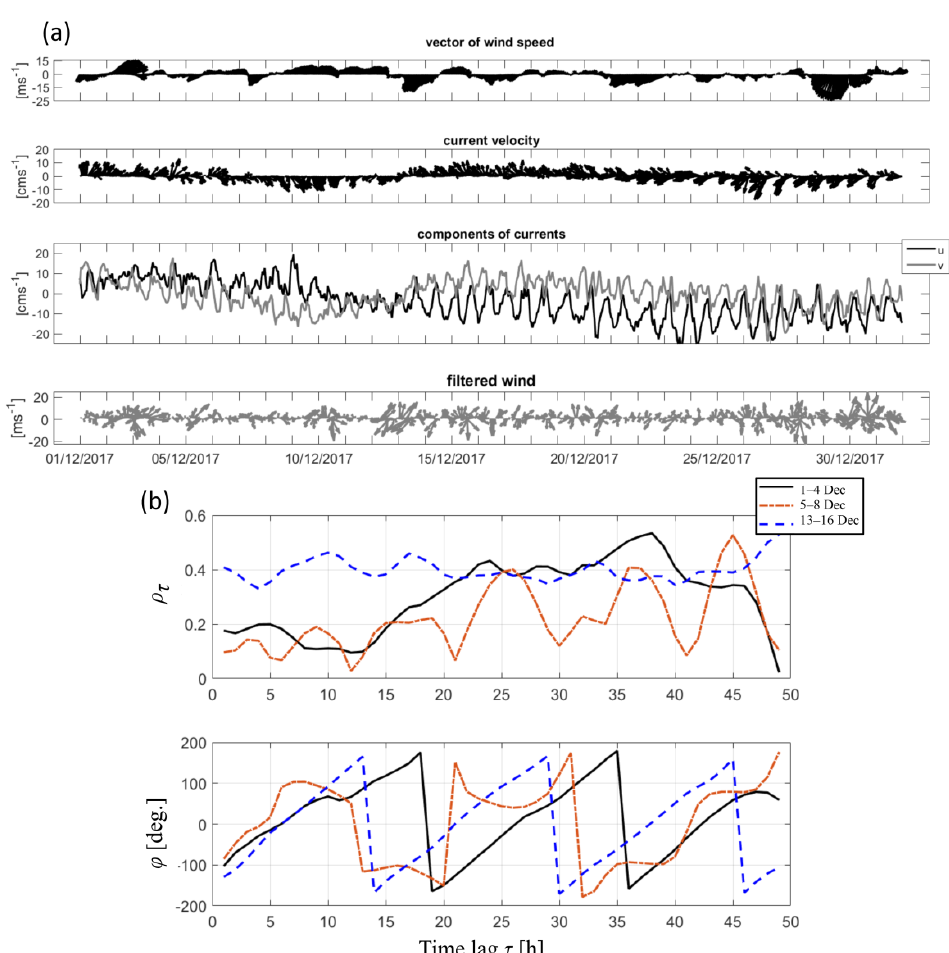
Figure 8. ( a ) Top—wind speed U ( t ) vector plot from the ERA-5 meteorological reanalysis data. The second plot from the top is the current velocity u ( t ) at 100 m at ABS No. 1 in December 2016, and the third plot from the top shows the u - and v -components of the current velocity. Bottom—wind speed after band-pass filtering for 22–26 h. ( b ) Top—lagged correlations ρ τ between the wind and current vectors for 1–4, 5–8, and 13–16 December 2016, bottom—the angle ϕ of rotation of the current velocity vector relative to the wind velocity vector.